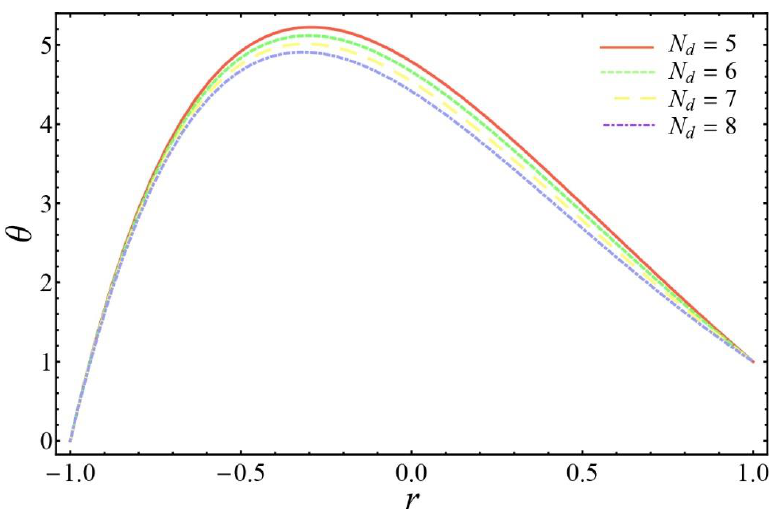
Figure 6. Alteration of 𝑁 𝑑 on θ when 𝑥 = 0.5; 𝑡 = 0; 𝑄 = 10; 𝛽 = 0.2; 𝜖 = 0.6; 𝑁 𝑡 = 5; 𝑁 𝑏 = 2; 𝑘 = 2.